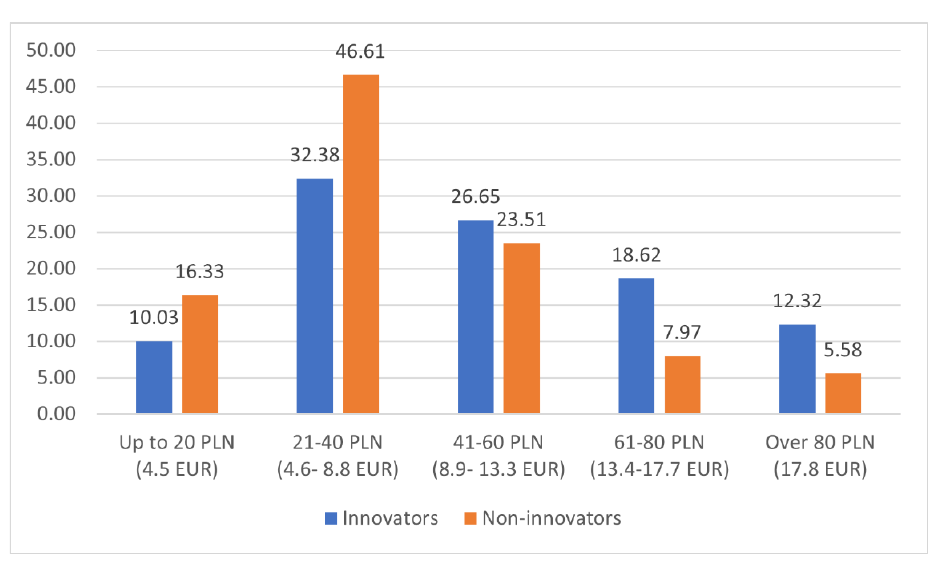
Figure 3. Weekly expenses on fruits and fruit preserves by innovators and non-innovators.